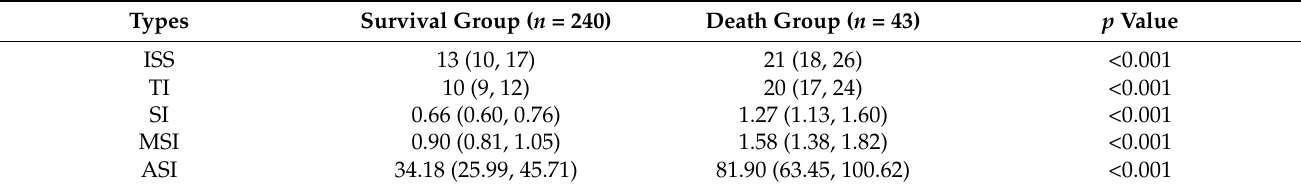
Table 2. Comparison of different trauma assessment tools between survival and death groups.